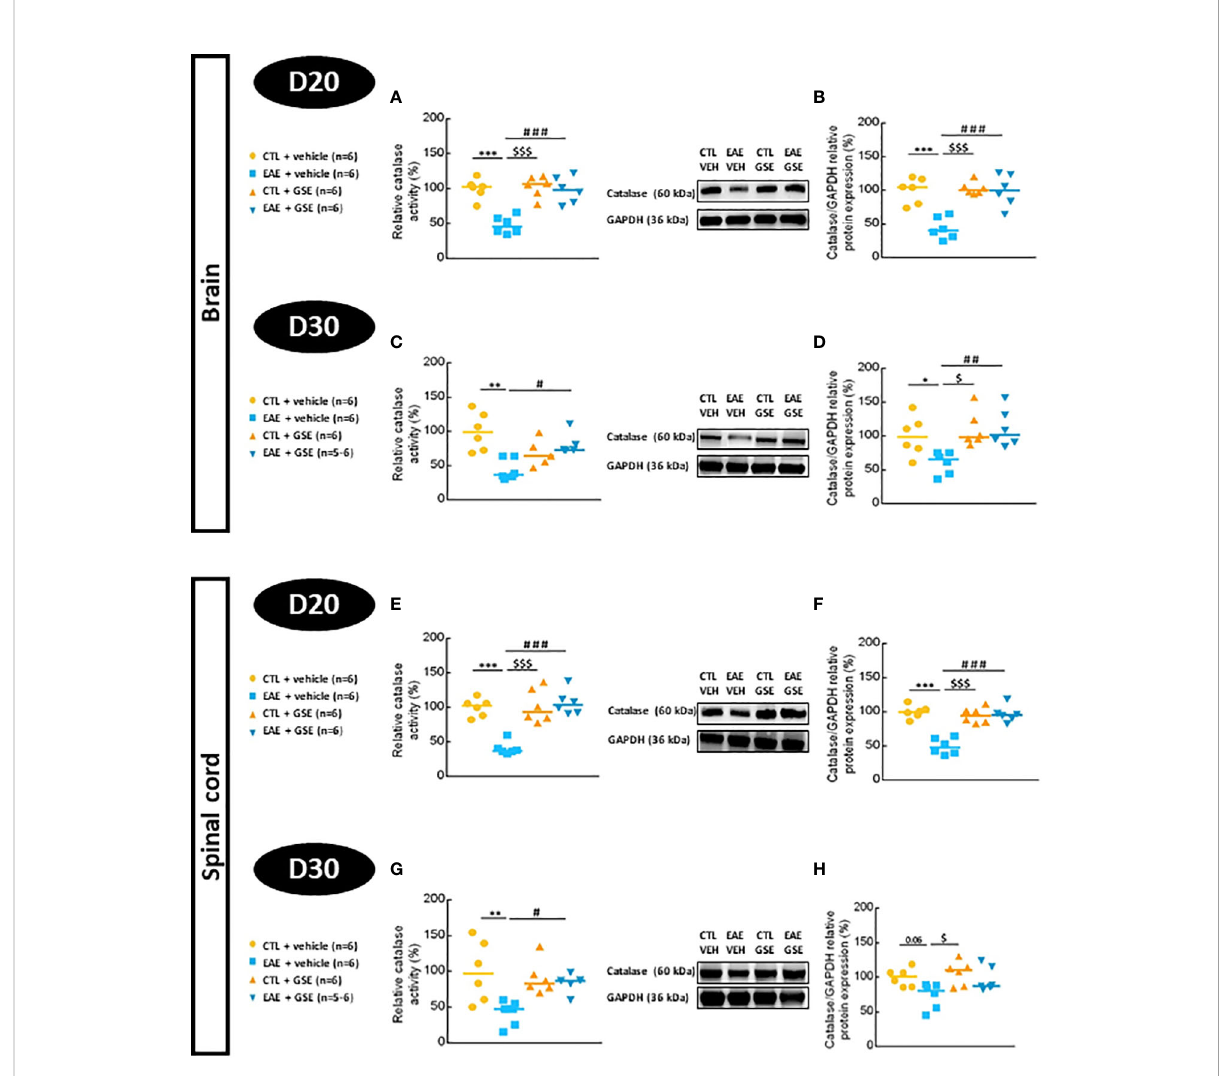
FIGURE 5 Evaluation of catalase activity and protein expression in the brain and spinal cord of experimental autoimmune encephalomyelitis mice (EAE) and their controls (CTL) after curative treatment with grape seed extract (GSE) or vehicle. Catalase activity was expressed as the relative activity (%) compared to CTL + vehicle group, in the brain (A, C) and the spinal cord (E, G) at D20 (A, E) or D30 (C, G) post-induction. Catalase/GAPDH protein expression was expressed as the relative protein expression (%) compared to CTL + vehicle group, in the brain (B, D) and the spinal cord (F, H) at D20 (B, F) or D30 (D, H) post-induction. For each protein level quanti fi cation, a representative Western blotting image of the target protein and loading control is proposed. Statistical analysis was performed using one-way ANOVA followed by Tukey ’ s multiple comparison test: *p < 0.05, **p < 0.01, ***p < 0.001 EAE + vehicle vs CTL + vehicle; #p < 0.05, ##p < 0.01, ###p < 0.001 EAE + GSE vs EAE + vehicle and $p < 0.05, $$$p < 0.001 EAE + vehicle vs CTL +